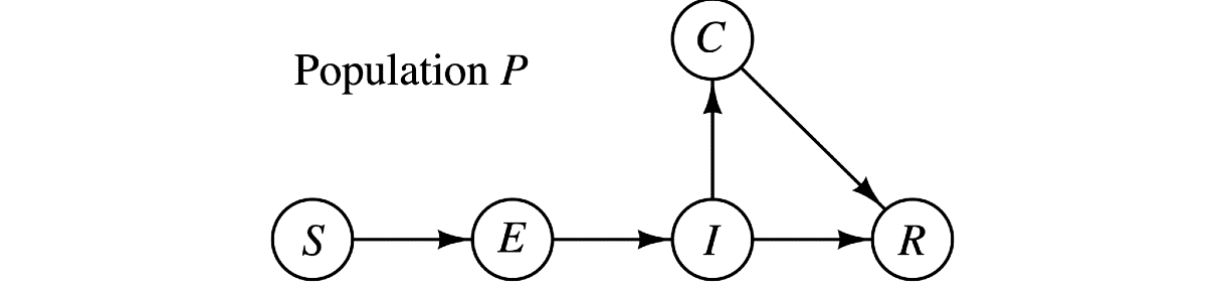
Figure 1. State transition flow chart. C: confirmed; E: exposed; I: infected; R: removed; S: